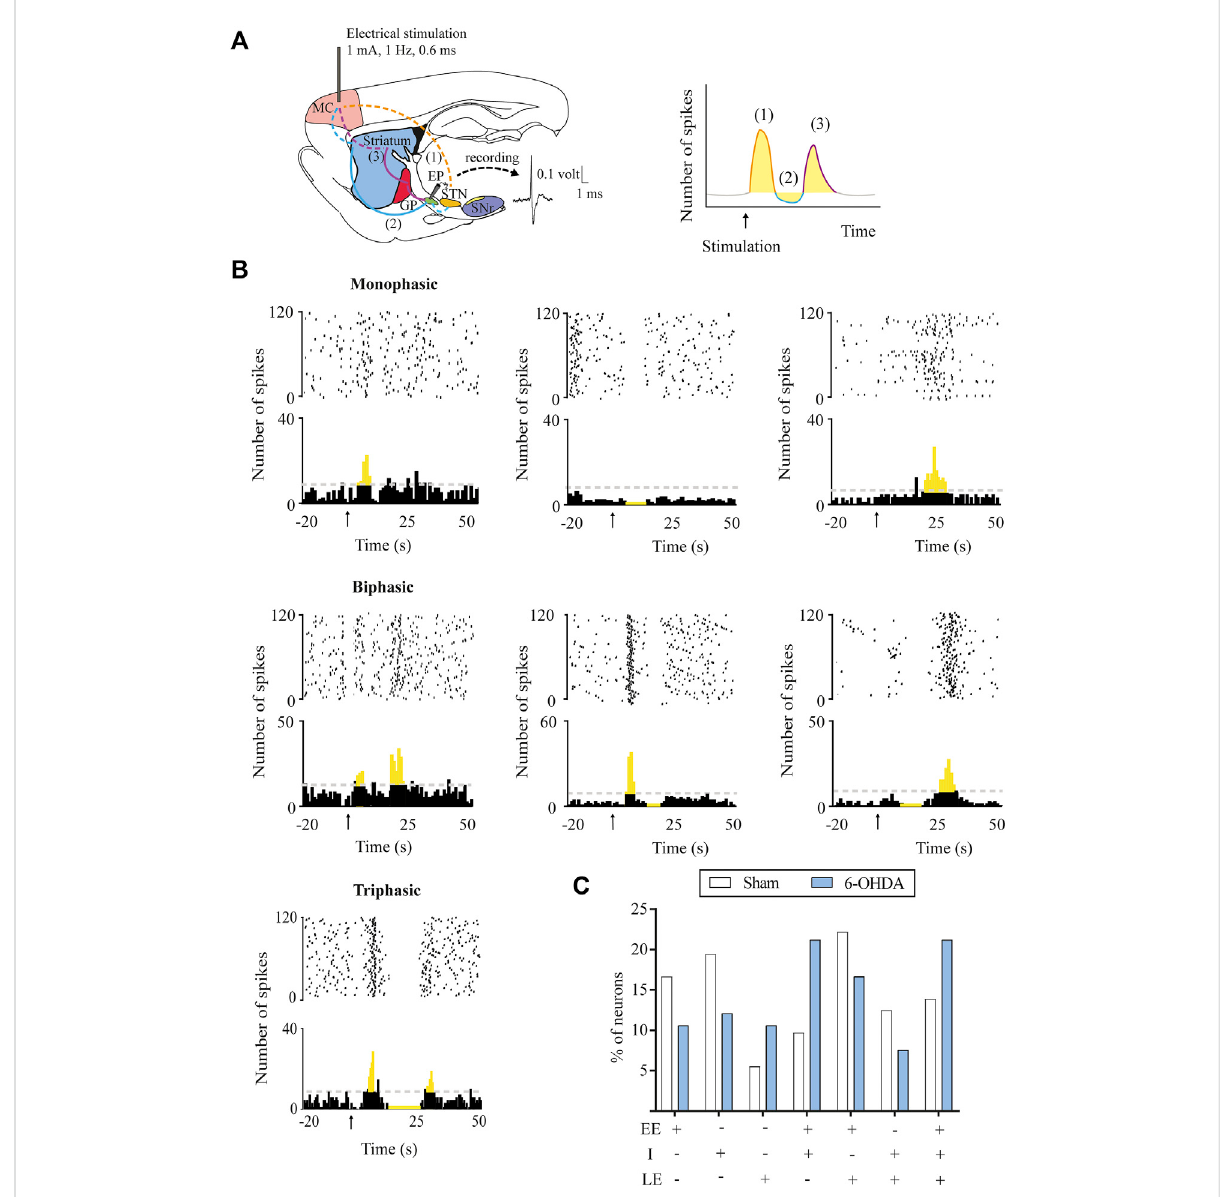
glutamatergicprojectionsandsolidlines,GABAergicprojections.Ontheright,rasterplotandperistimulustimehistogramshowingthecharacteristic cortically evoked triphasic response in EP neurons: 1) early excitation (EE) in yellow: activation of hyperdirect pathway (cortex-STN-SNr), 2) inhibition (I) in blue: activation of direct pathway (cortex-striatum-EP), and 3) late excitation (LE) in red: activation of indirect pathway (cortex- striatum-GPe-STN-EP). (B) Raster plot and peristimulus time histogram showing the different representative examples of a monophasic, biphasic, and triphasic response evoked in an EP neuron. (C) DA loss did not alter the percentage of SNr neurons displaying different patterns of